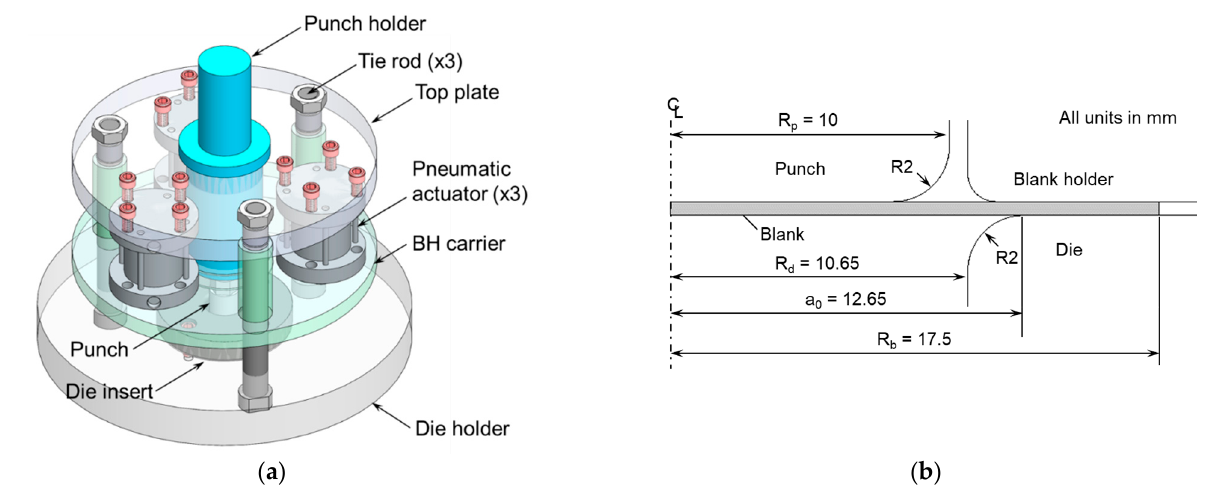
Figure 3. ( a ) Solid model of the tooling. ( b ) Geometry of the tooling and blank (using symmetry).